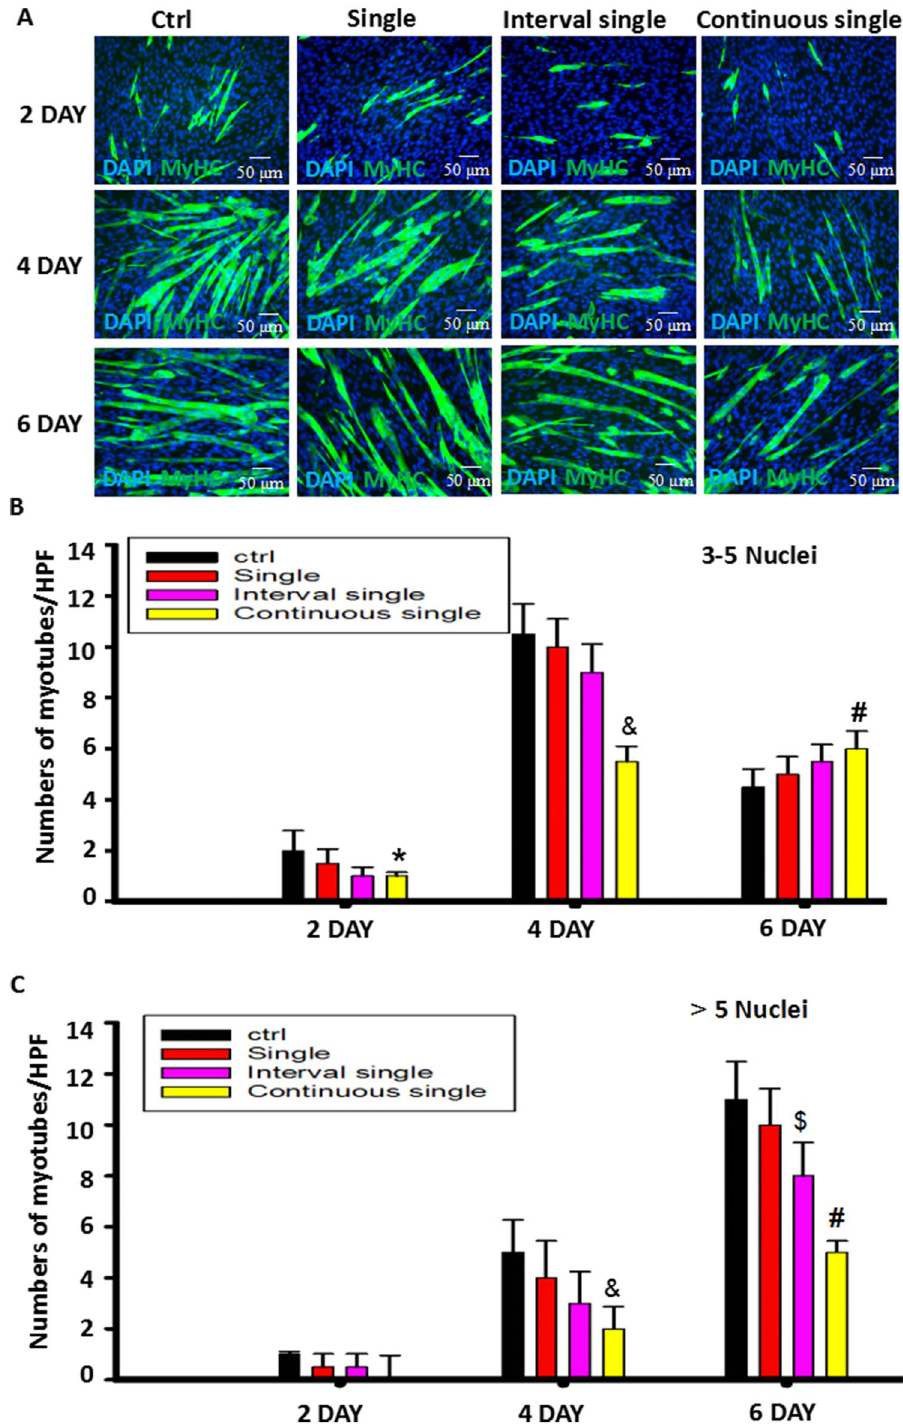
Figure 1. Continuous stimulation with ISO most obviously inhibited C2C12 cell differentiation and myoblast fusion. ( A ) Typical image of MyHC staining in differentiated C2C12 myoblast cells exposed to different delivery methods of ISO. ( B ) A quantitative assay for the number of MyHC + myotubes with 3–5 nuclei was performed 2, 4 and 6 days after myoblast differentiation following stimulation with ISO delivered with single, interval single or continuous single doses. n = 3, # P < 0.05 versus Ctrl. ( C ) A quantitative assay for the number of MyHC + myotubes with more than 5 nuclei was performed 2, 4 and 6 days after myoblast differentiation following stimulation with ISO delivered with single, interval single or continuous single doses. n = 3, & P < 0.05 versus Ctrl; # P < 0.05 versus Ctrl, single or interval single group; $ P < 0.05 versus